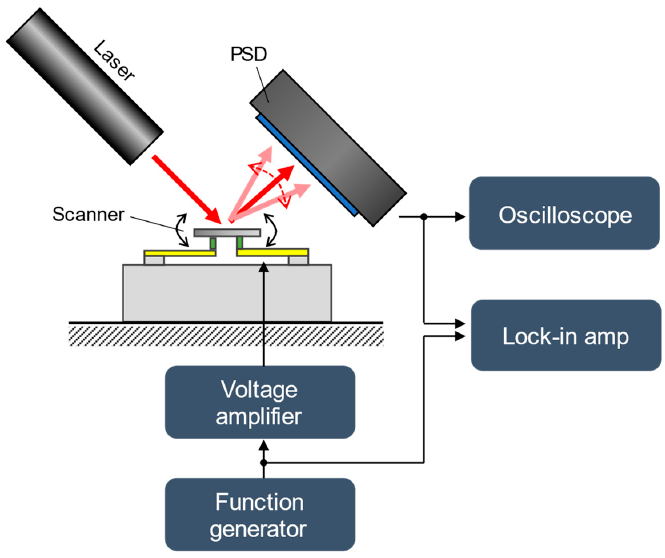
Figure 6. Schematics of the evaluation setup.